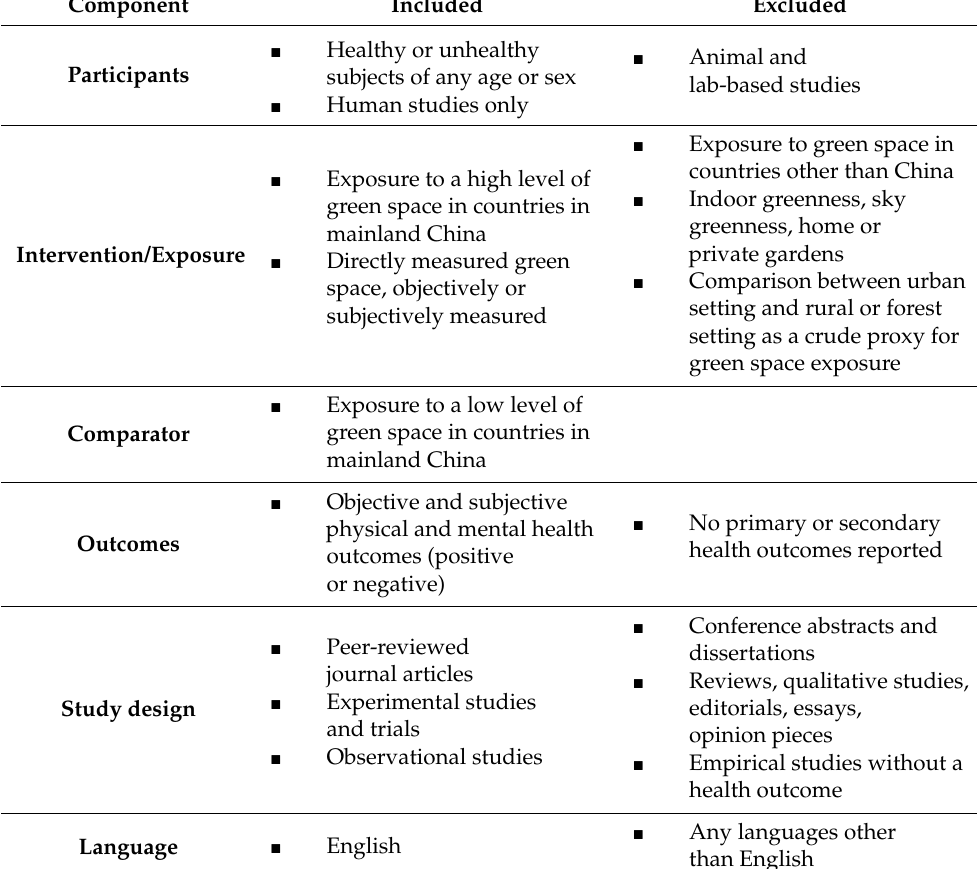
Table 1. Inclusion and exclusion criteria of the